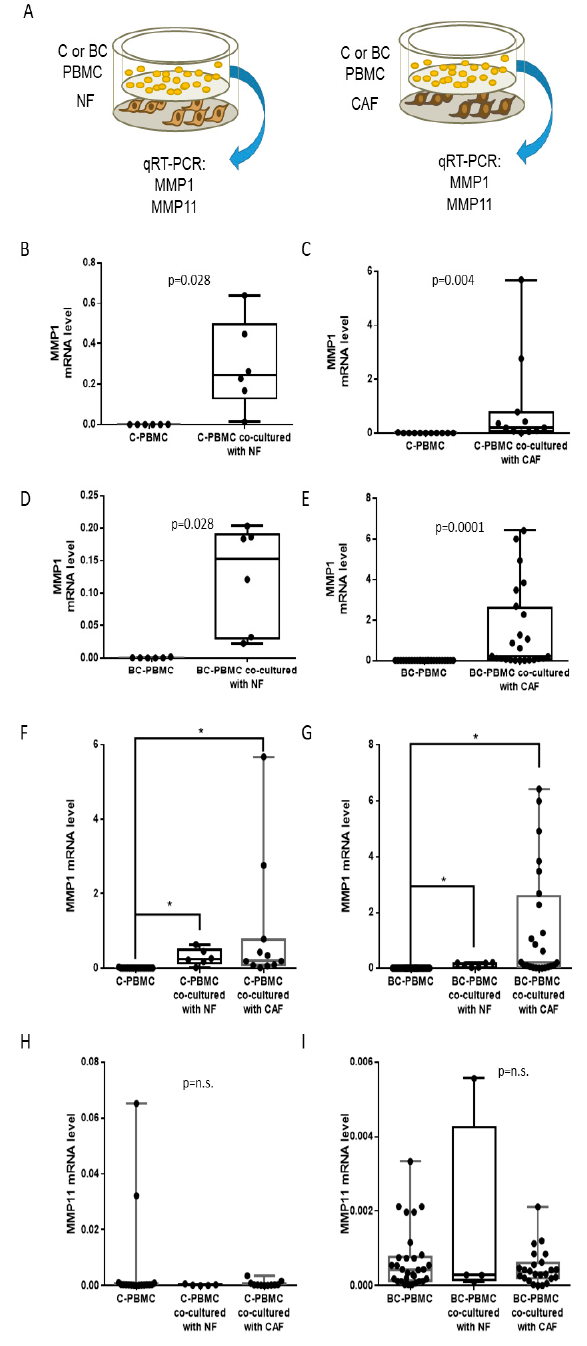
Figure 3. MMP1 and MMP11 gene expression in PBMC after co-culture with normal fibroblasts (NF) and cancer-associated fibroblasts (CAF). Scheme of experimental design ( A ). MMP1 gene expression in PBMC from healthy women (controls, C-PBMC) before and after co-culture with NF ( n = 6) and CAF ( n = 11) ( B , C ), and in PBMC from breast cancer patients (BC-PBMC) before and after co-culture with NF ( n = 6) or CAF ( n = 24) ( D , E ). Comparative of the MMP1 gene expression in C-PBMC and BC-PBMC after co-culture with NF ( n = 6) and CAF ( n = 11) ( F , G ). Comparative of the MMP11 gene expression in C-PBMC and BC-PBMC after co-culture with NF ( n = 6) or CAF ( n = 24) ( H , I ). Data represent the mean ± SD. (* p ≤ 0.05; n.s.: not significant). Results of the qRT-PCR data were represented as ΔΔ CT values.